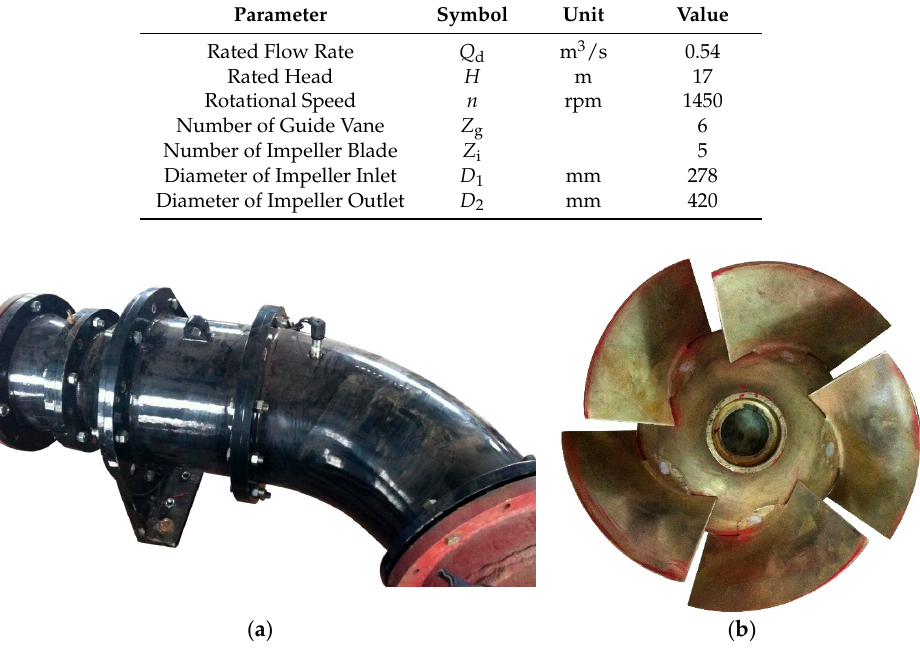
Figure 1. ( a ) Pump and ( b ) impeller in experimental measurement.